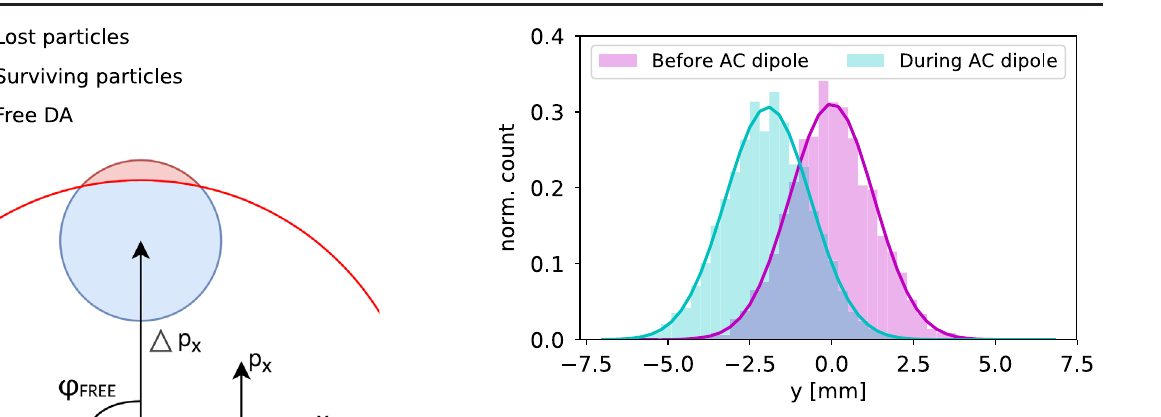
FIG. 10. Bunch distributions for vertical excitations of ac dipole for the case before the ac dipole (at rest) and during the flattop ac dipole excitation for multiparticle tracking simu- lations with 4000 particles. Before the ac dipole the bunch size is σ ¼ 1 . 305 mm, and during the flattop ac dipole excitation it is measured at σ ¼ 1 . 309